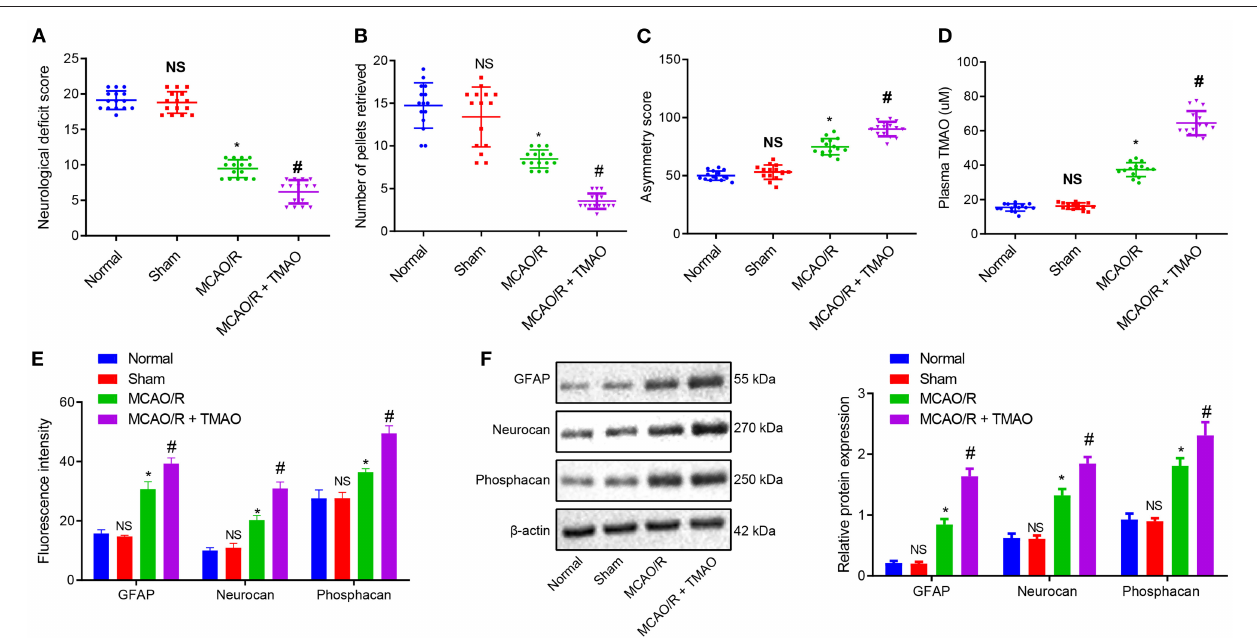
FIGURE 1 | Proliferation of reactive astrocytes and glial scarring is promoted by TMAO. (A) Evaluation of neurological function on MCAO/R rats treated with TMAO. (B) Number of collected chow pellets detected by staircase test in MCAO/R rats treated with TMAO. (C) Scoring results of asymmetry by cylinder test in MCAO/R rats treated with TMAO. (D) Statistical results of TMAO concentration in brain tissues of MCAO/R rats treated with TMAO. (E) Expression of GFAP, Neurocan, and Phophacan detected by immunofluorescence assay in brain tissues of MCAO/R rats treated with TMAO. (F) Expression of GFAP, Neurocan, and Phosphacan determined by Western blotting in brain tissues of MCAO/R rats treated with TMAO. * p < 0.05 compared with sham-operated rats ( n = 15). # p < 0.05 compared with MCAO/R rats ( n = 15). NS p > 0.05 compared with the control rats ( n = 15). One-way ANOVA is employed for data comparison among multiple groups followed by Tukey’s post hoc test.